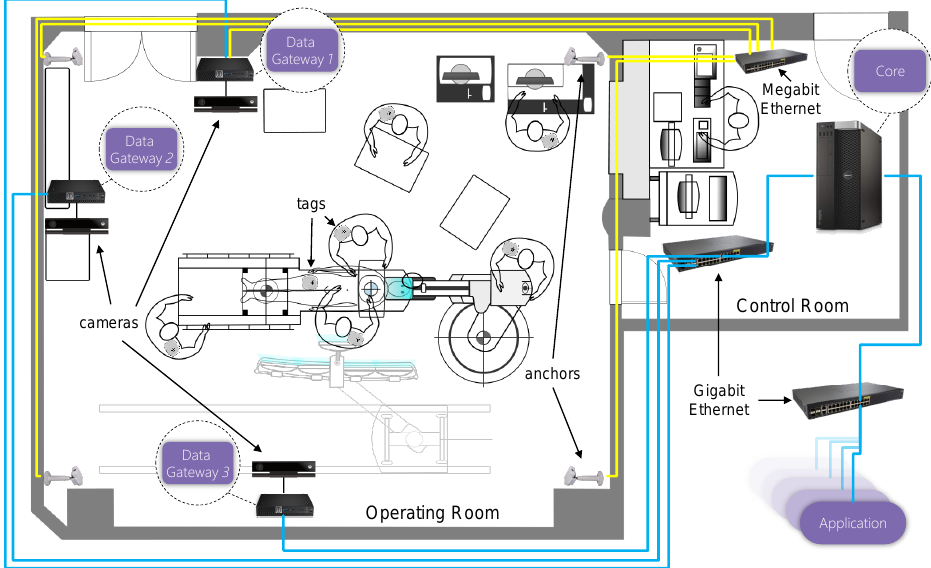
Figure 4. Deployment of the architecture in a real operating room. Three camera devices and several tags track the surgery